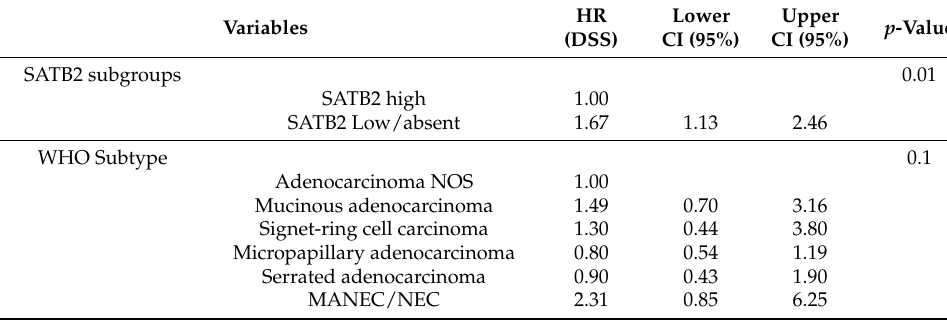
Table 4. Multivariate disease-specific survival analysis in the high tumour budding (Bd3) subcohort under inclusion of SATB2 expression, age, gender, CRC subtype, UICC stage, WHO grade, resection status and microsatellite